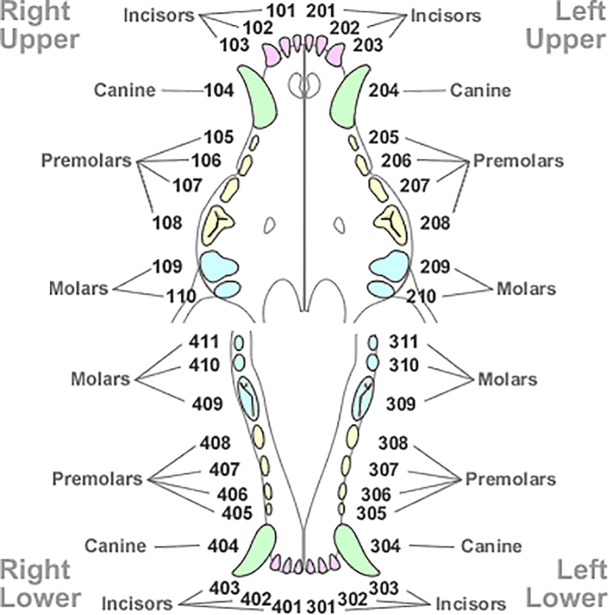
The TRIDAN modified system for dog teeth classification.Adapted from Crossley [32].